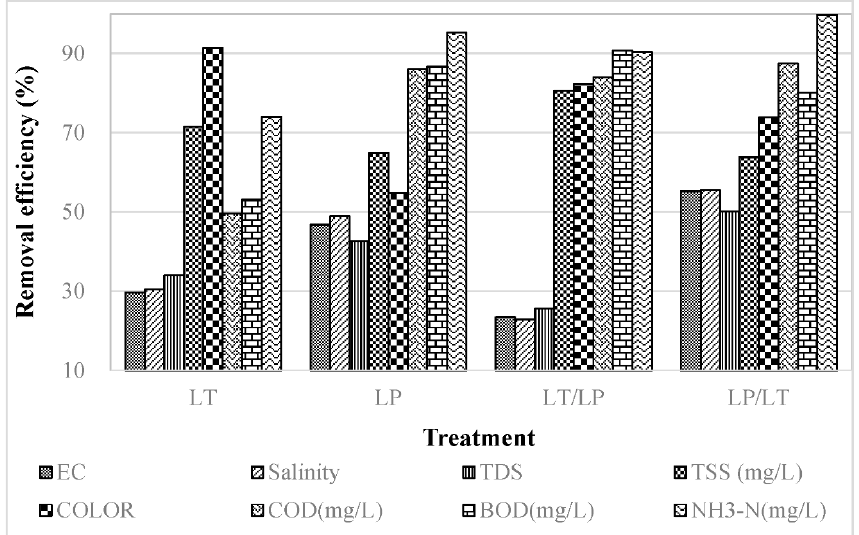
Figure 1. Reduction e ffi ciencies for the physicochemical parameters in the four treatment